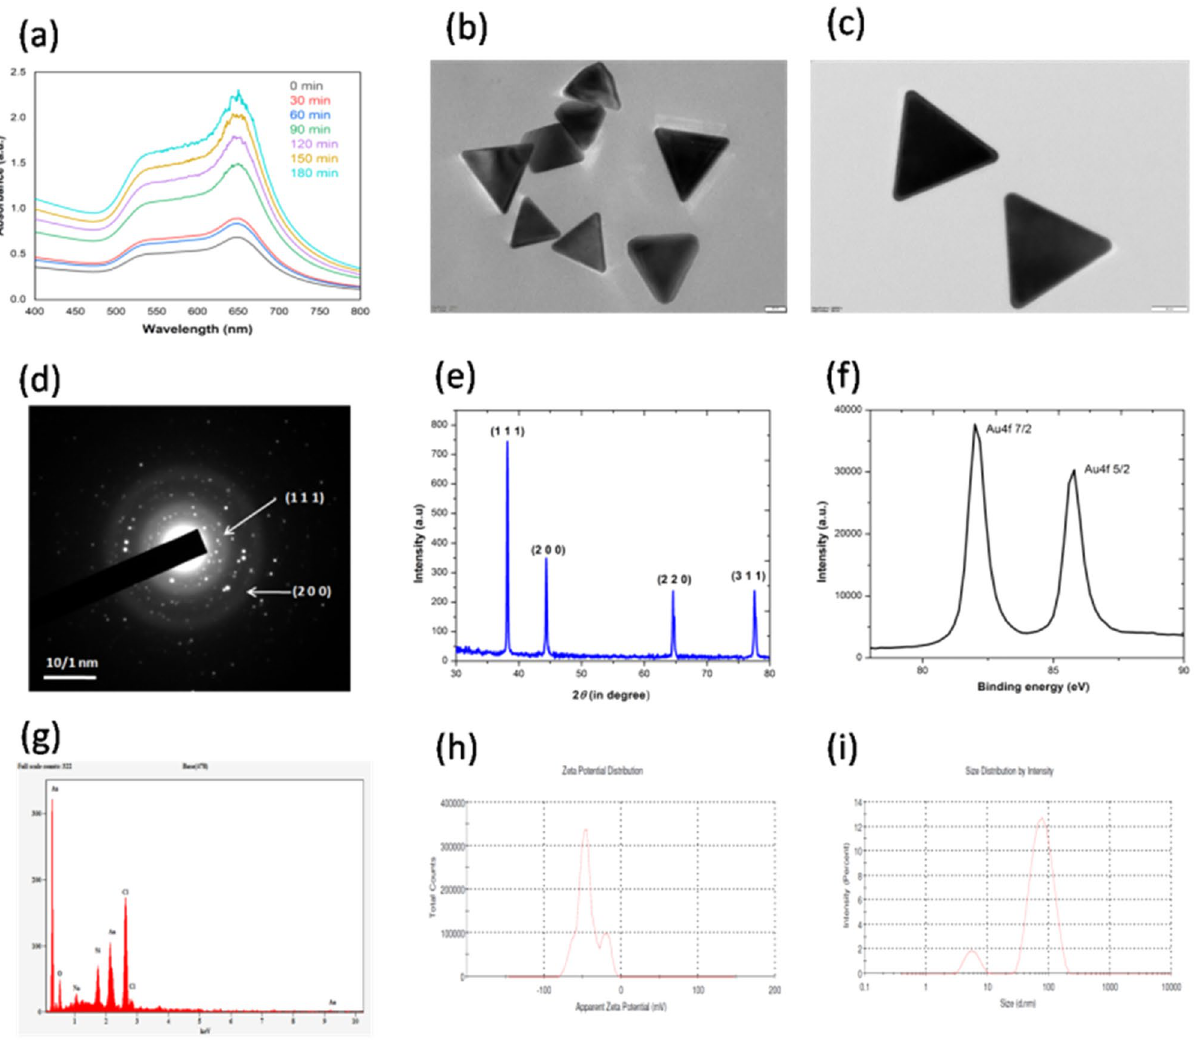
Figure 2. Optical and structural characterization of PSS@CTAC©AuNTs in DI water. ( a ) UV– vis absorption spectra at various time intervals (0–180 min). ( b , c ) TEM and HR-TEM micrographs. ( d ) SAED pattern. ( e ) X-ray diffraction pattern (JCPDS No. 04-0784). ( f ) A typical XPS spectrum. (g) Elemental mapping by EDAX. (h) Apparent zeta potential value (− 42.9 ± 5.45 mV). ( i ) Size distribution by intensity (51.643 ± 8.8